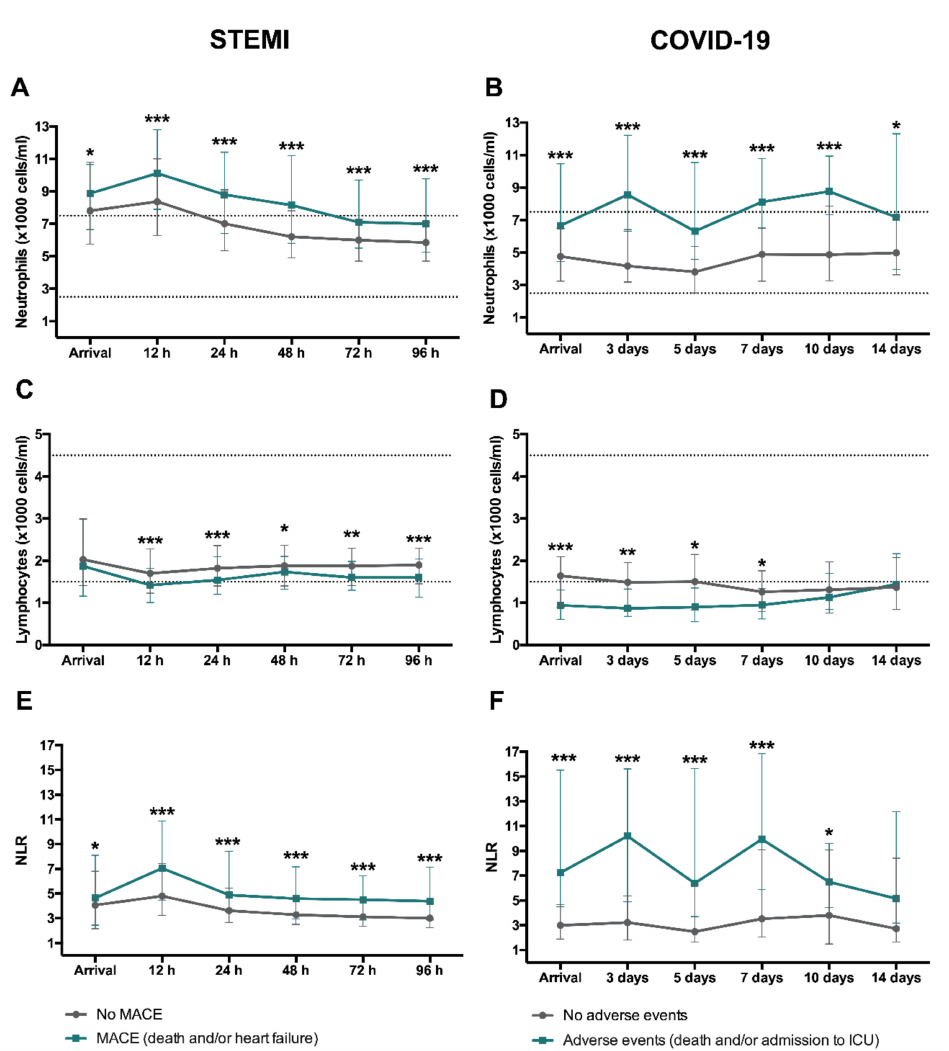
Figure 5. Time course of neutrophil and lymphocyte counts and NLR according to occurrence of adverse events. In STEMI ( n = 659), MACE included death, and readmission for heart failure. Evolution of median neutrophil ( A ) and lymphocyte ( C ) ( × 1000 cells / mL) counts as well as NLR ( E ) according to MACE. In COVID-19 patients ( n = 103), adverse events were defined as death and / or admission in ICU. Dynamics of median neutrophil ( B ) and lymphocyte ( D ) ( × 1000 cells / mL) counts as well as NLR ( F ) according to adverse events. Data were expressed as median [quartile 25-quartile 75]. Dotted lines represent the upper and lower ranges of normality. * p < 0.05, ** p < 0.01, *** p < 0.001. COVID-19: coronavirus disease 2019; ICU: intensive care unit; MACE: major adverse cardiac events; NLR: neutrophil-to-lymphocyte ratio; STEMI: ST-segment elevation myocardial